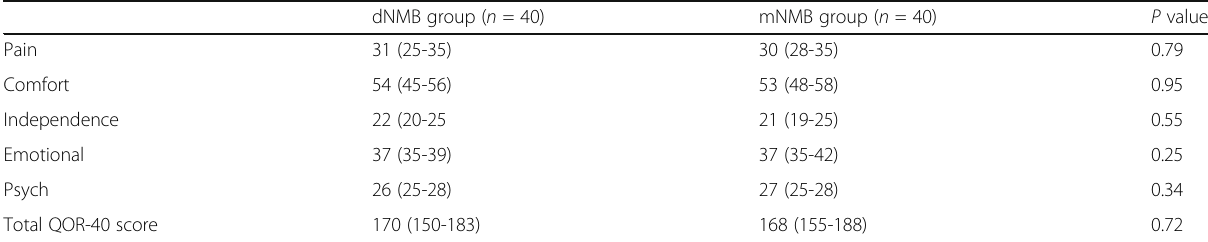
Table 3 Subcomponents and total postoperative QOR-40 score. Values are median (range) dNMB group ( n = 40) mNMB group ( n =